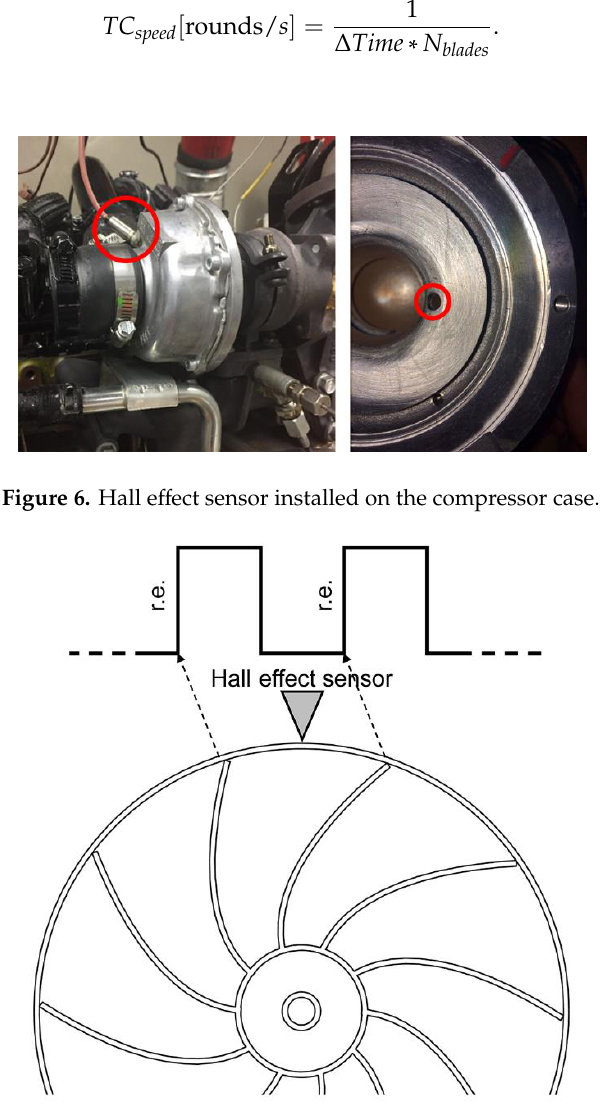
Figure 7. Schematic representation of the operation of the Hall effect sensor mounted on the compressor.